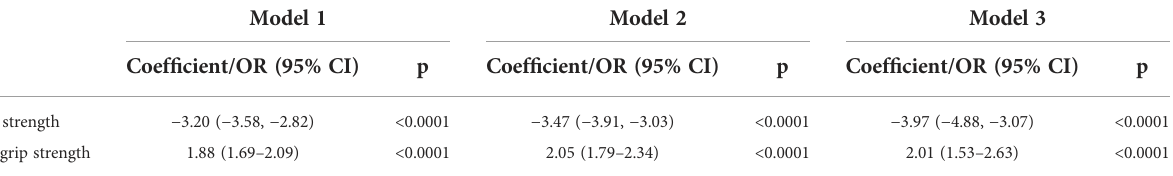
TABLE 3 Muscle strength outcomes by adjustment